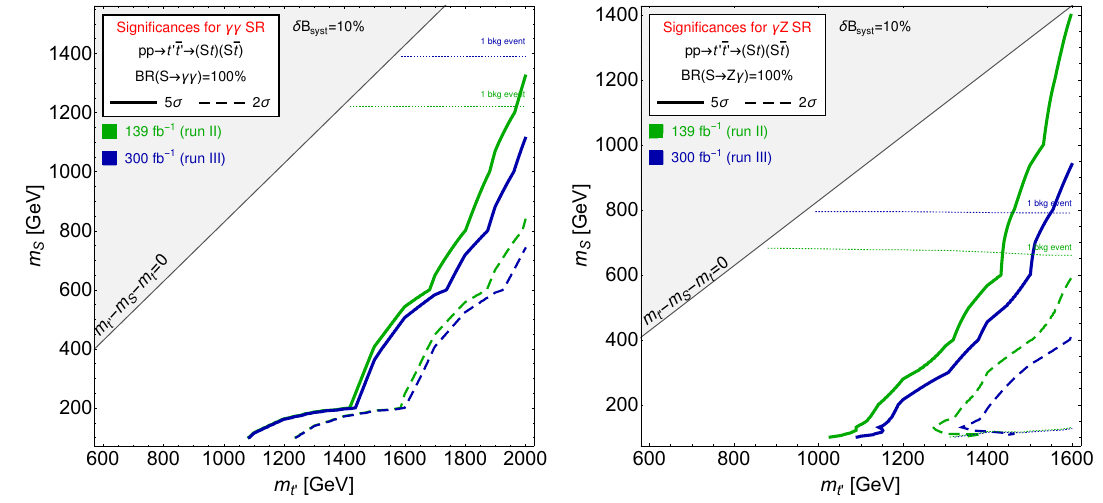
Figure 10 . LHC optimal reach for di(cid:11)erent LHC luminosities for the (cid:13) (cid:13) SR (left) and Z (cid:13) SR (right). The solid lines correspond to the 5 (cid:27) discovery reach, while the dashed lines correspond to the 2 (cid:27) exclusion reach. The dotted lines identify the region with 1 irreducible background event, where the contribution of fake rates can become